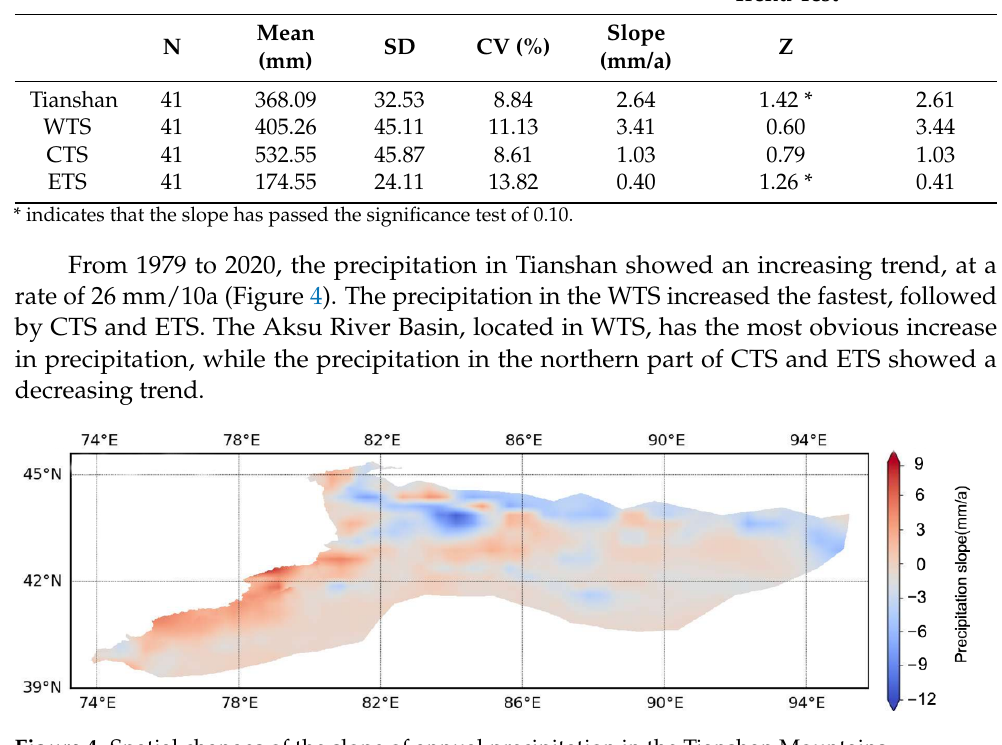
Figure 5. Global average surface temperature anomaly from 1850 to 2020 (relative to the average value from 1970 to 2000). In recent years, with global warming, the global average precipitation has shown an increasing trend [2]. How does the precipitation in Tianshan respond to global warming? Figure 6 shows the scatter plots between precipitation and global temperature on a monthly scale. In Tianshan, the correlation coefficient between precipitation and global temperature is 0.88, indicating that the precipitation in Tianshan is sensitive to global warming. The CTS has the highest elevation and the most precipitation, and it is more sensitive to global warming than WTS and CTS. In WTS, CTS, and ETS, the correlation coefficient between precipitation and global temperature is 0.86, 0.87, and 0.78, respec- tively. Moreover, we also calculated the correlation coefficient between precipitation and local temperature, and the results are shown in Figure S1. In WTS, CTS and ETS, the cor- relation coefficients between precipitation and local temperature are 0.84, 0.87, and 0.78, respectively, which are close to that of global temperature. The above results indicate that the precipitation in the Tianshan Mountains is sensitive to warming. The formation mech- anism of regional precipitation is complex. There are many properties of convection that